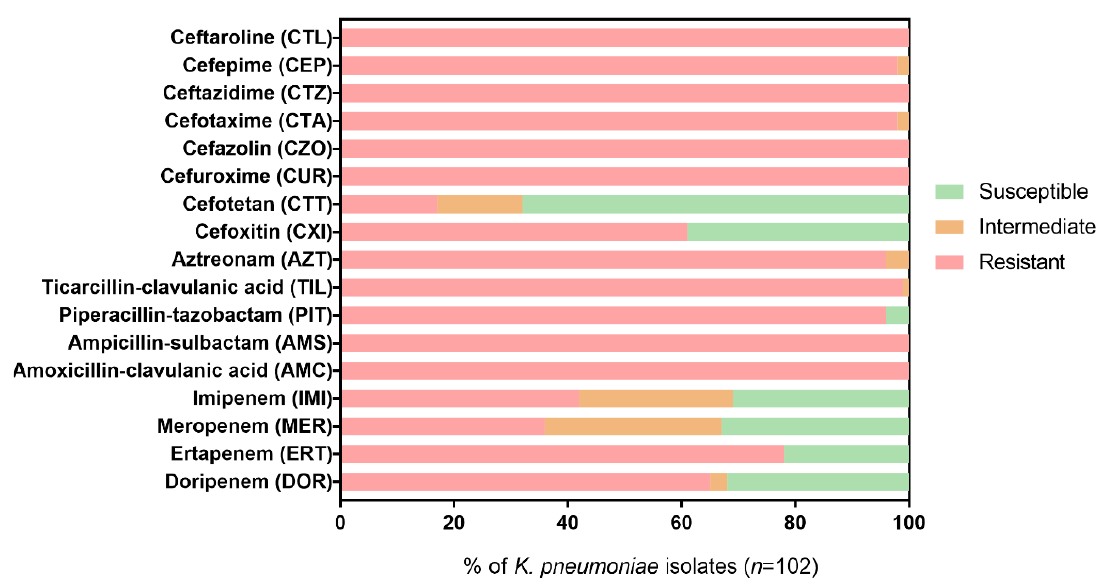
Figure 2. Antibiotic resistance portfolio of K. pneumoniae isolates determined according to EUCAST criteria. Cefotetan (CTT) is not included in EUCAST breakpoints guidelines, so we used the CLSI criteria. Note. The percentage of K. pneumoniae considered resistant according to the guidelines was statistically different from the % of isolates classified as intermediate or susceptible (one-way ANOVA with Holm-Sidak’s multiple comparisons tests; p < 0.05).